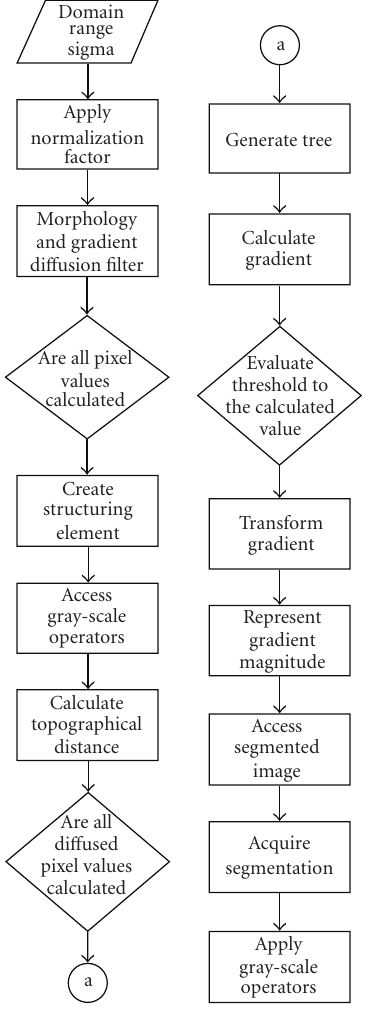
Figure 6: Program flowchart for contour extraction.